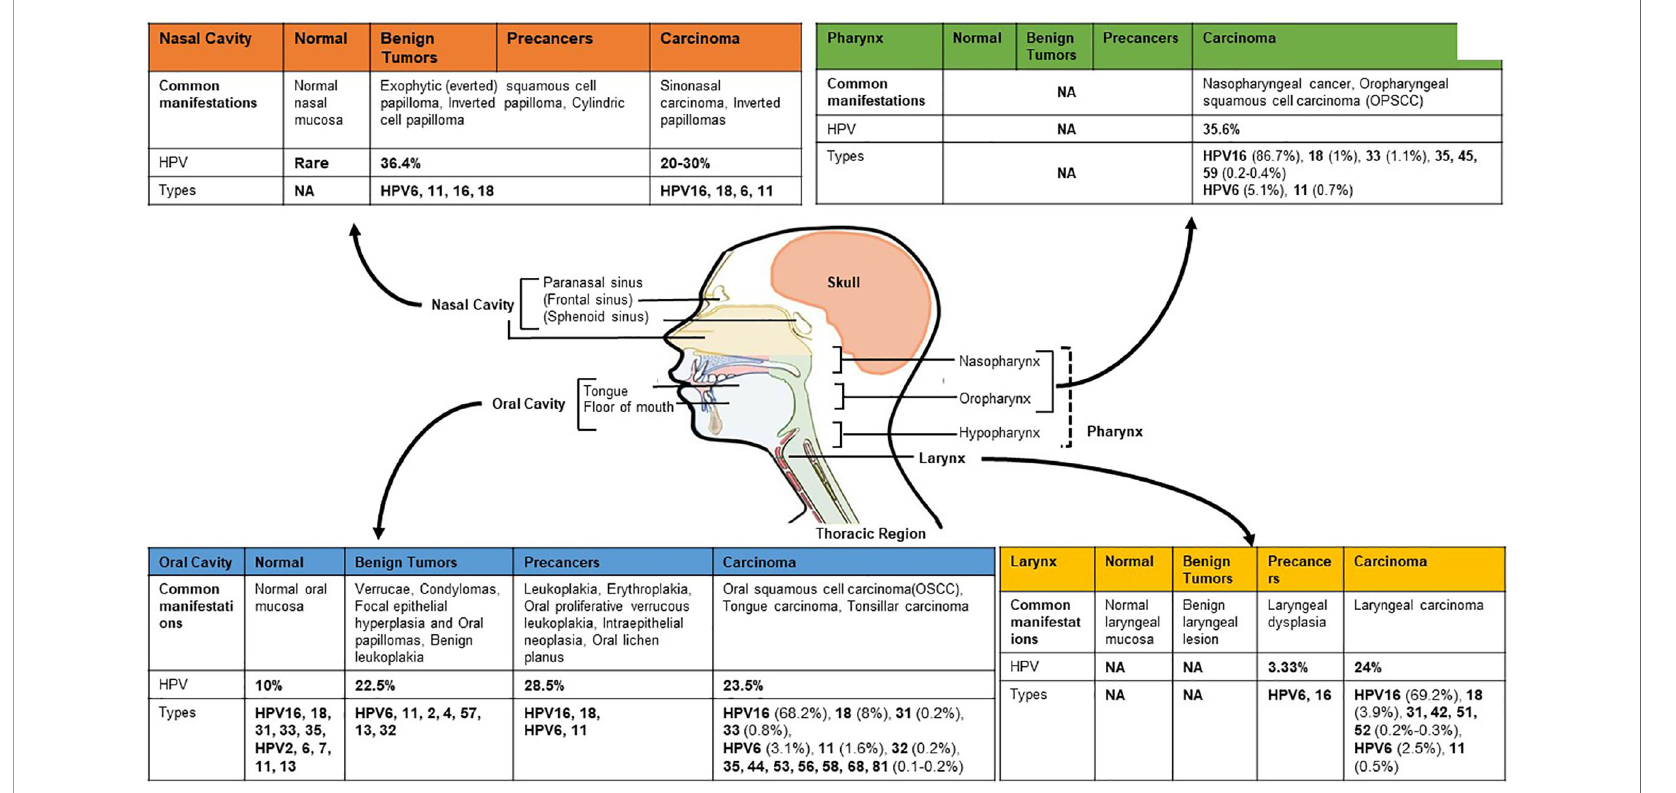
FIGURE 1 | HPV footprint in different anatomical sub-site of head and neck region. Site-wise HPV prevalence and type distribution in different regions of head and neck broadly classi fi ed as oral cavity (anterior and middle tongue, fl oor of the mouth, gingiva, gum, palate, lip mucosa and other sites of the mouth), pharynx (oropharynx with tonsils and base of tongue, nasopharynx, and hypopharynx), larynx and nasal cavity with paranasal sinus (frontal sinus, sphenoid sinus). Hypopharynx, which show low, or no HPV positivity, is sometimes included with laryngeal region for HPV prevalence studies. Data presented in the fi gure is derived from different systematic reviews and meta-analyses (Miller and Johnstone, 2001; Syrjanen, 2003; Kreimer et al., 2005; Sarkola et al., 2008; Rautava and Syrjanen, 2011; Syrjanen et al., 2017; Onerci Celebi et al., 2018). [Image originally produced by Macmillan Cancer Support and reused with